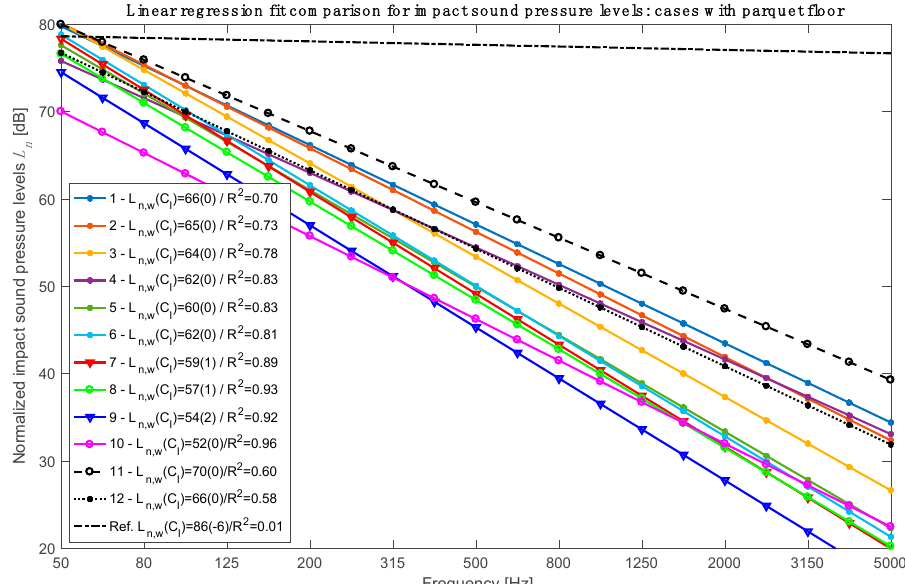
Figure 6. Linear models of the normalized impact sound pressure levels L n of the test floors. Airborne sound reduction fits and their slopes in Figure 5 present the linear trends of measurement curves. Floors 1 and 2 have the smallest slopes, after the reference curve,